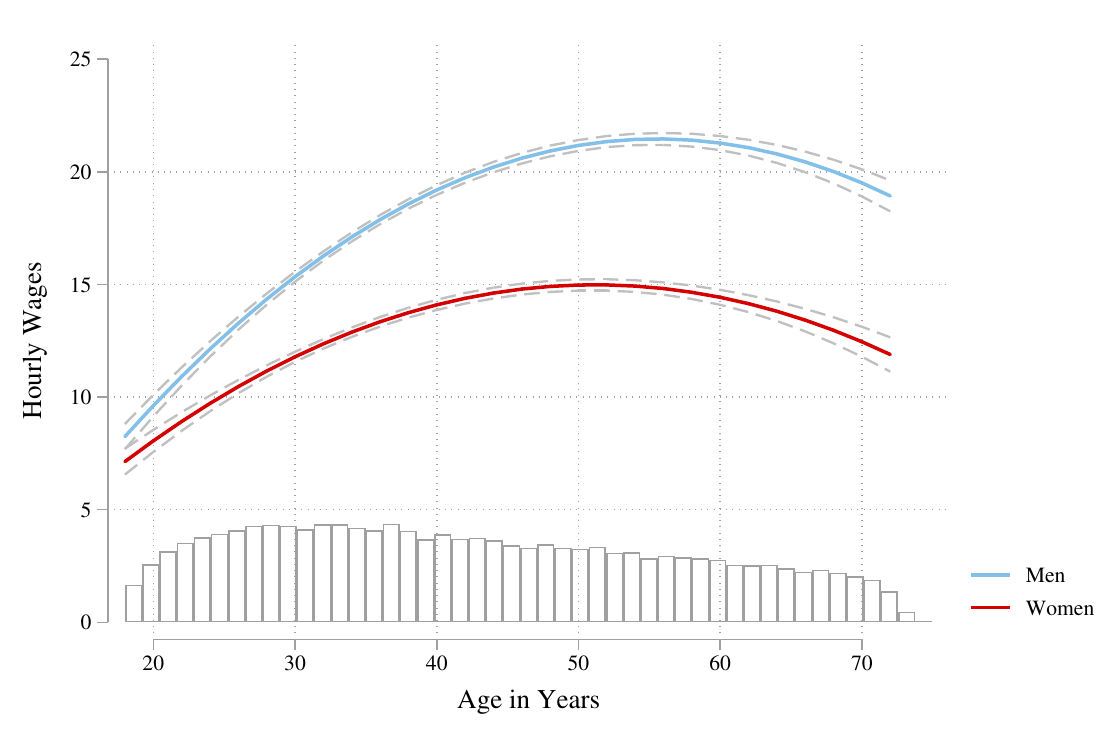
Figure 1: Predicted hourly wages based on age and gender: curvilinear effect of age and interaction effect between age and